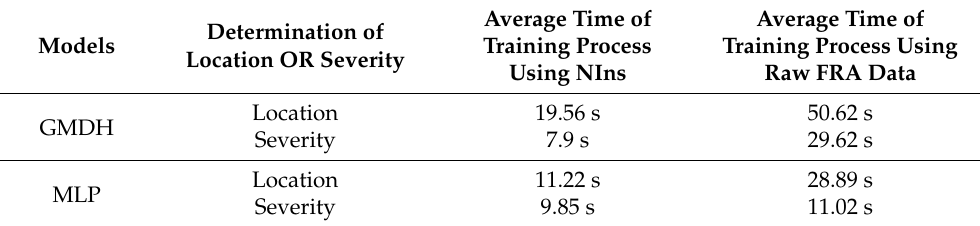
Table 2. Average time of training models with extracted features and raw FRA data.